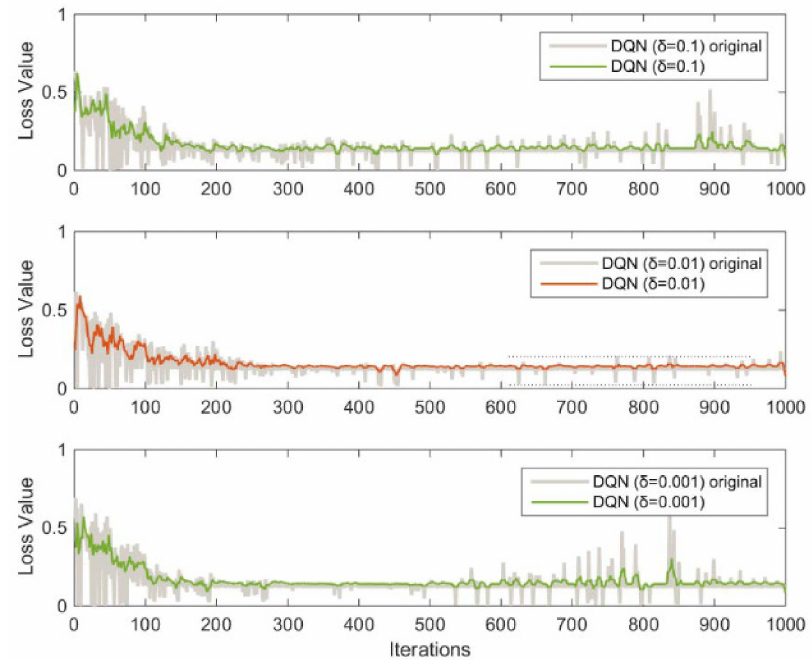
Figure 6. Performance of DQN using various Learning Rates (with and without profit